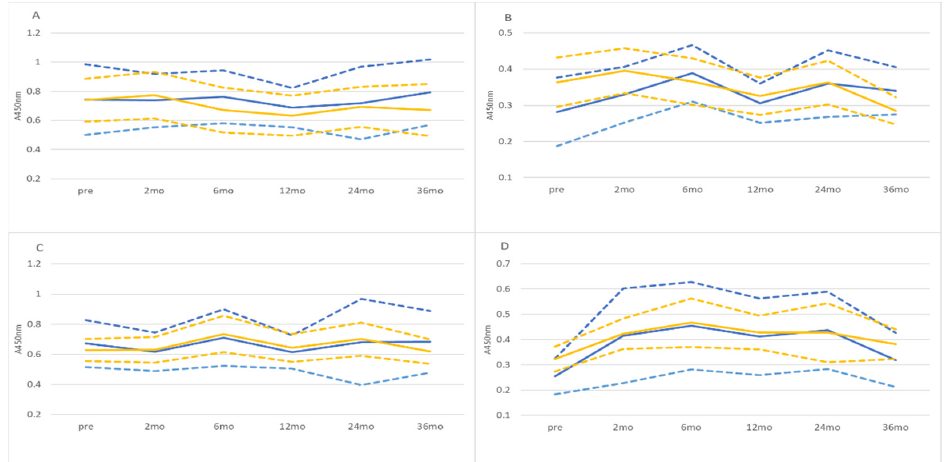
Figure 1. Dynamics of saliva and serum HPV16 L1 antibodies of women who had either persistent (blue lines) or transient (yellow lines) oral HPV16 infection. Mean: solid line, 95% confidence, upper and lower: dashed line. ( A ) saliva sIgA, ( B ) saliva IgG, ( C ) serum IgA, and ( D ) serum IgG.